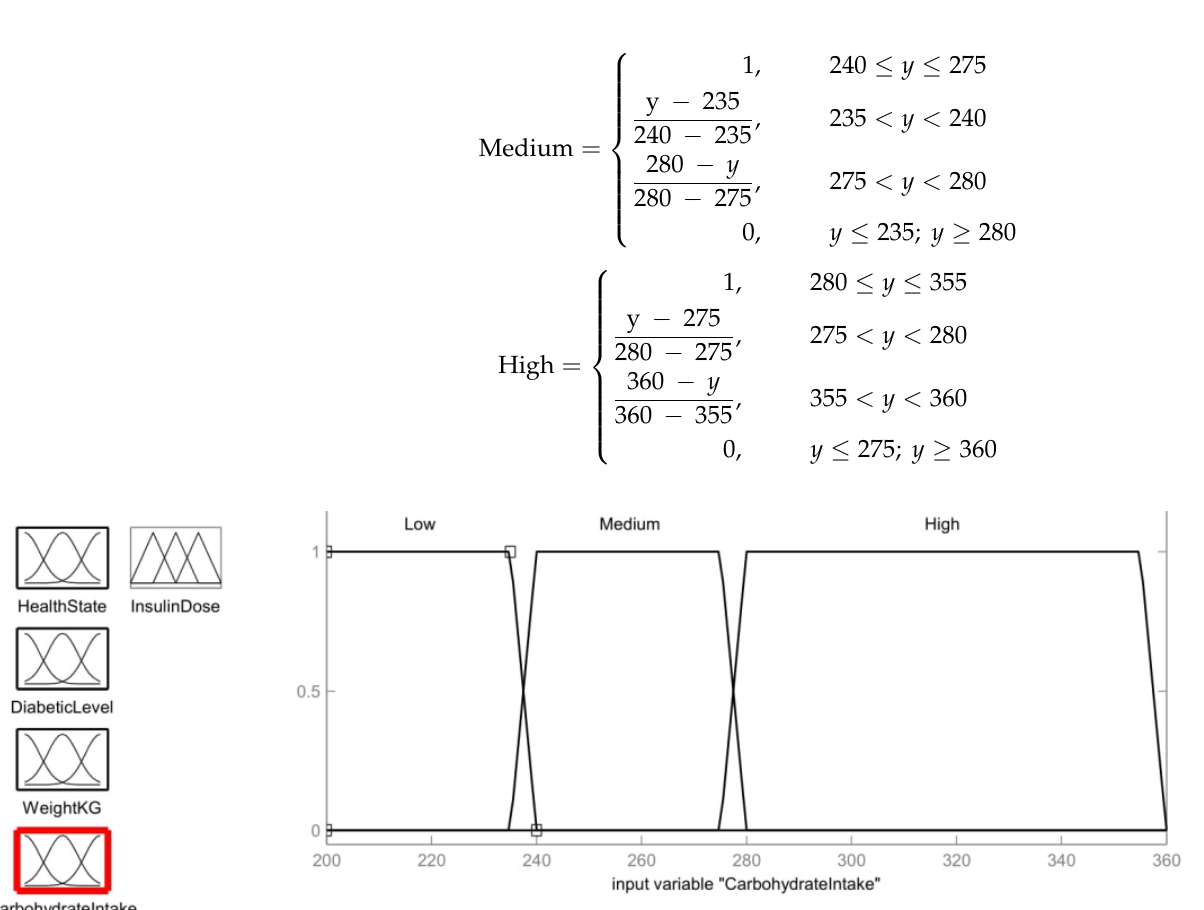
Figure 11. Carbohydrate Intake Membership function.